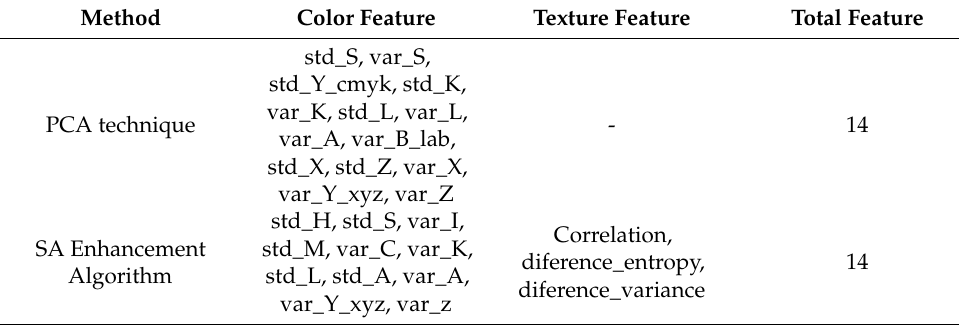
Table 6. Features selected by the PCA and